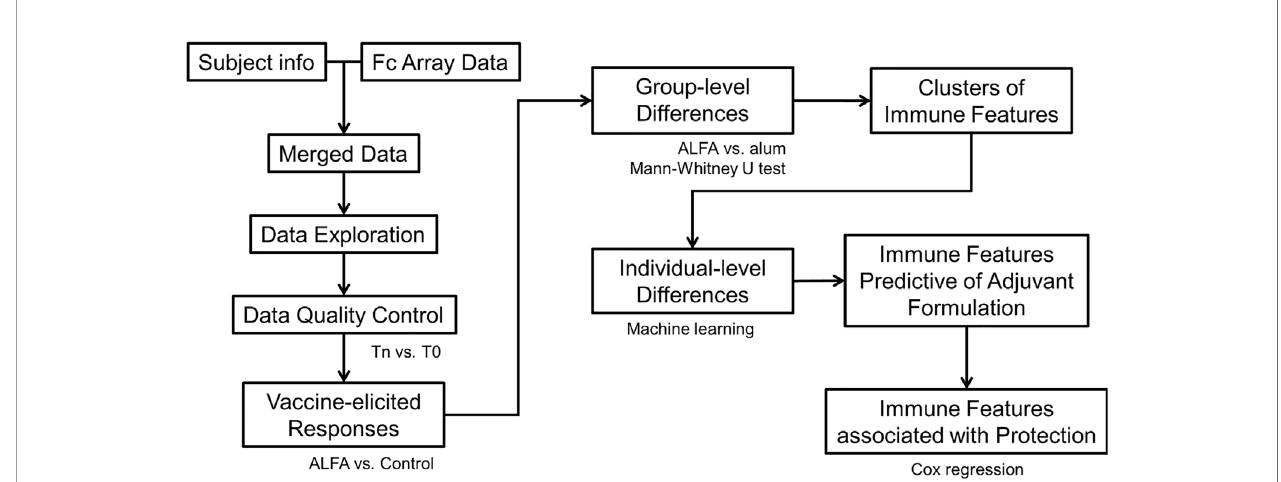
FIGURE 1 | Data analysis